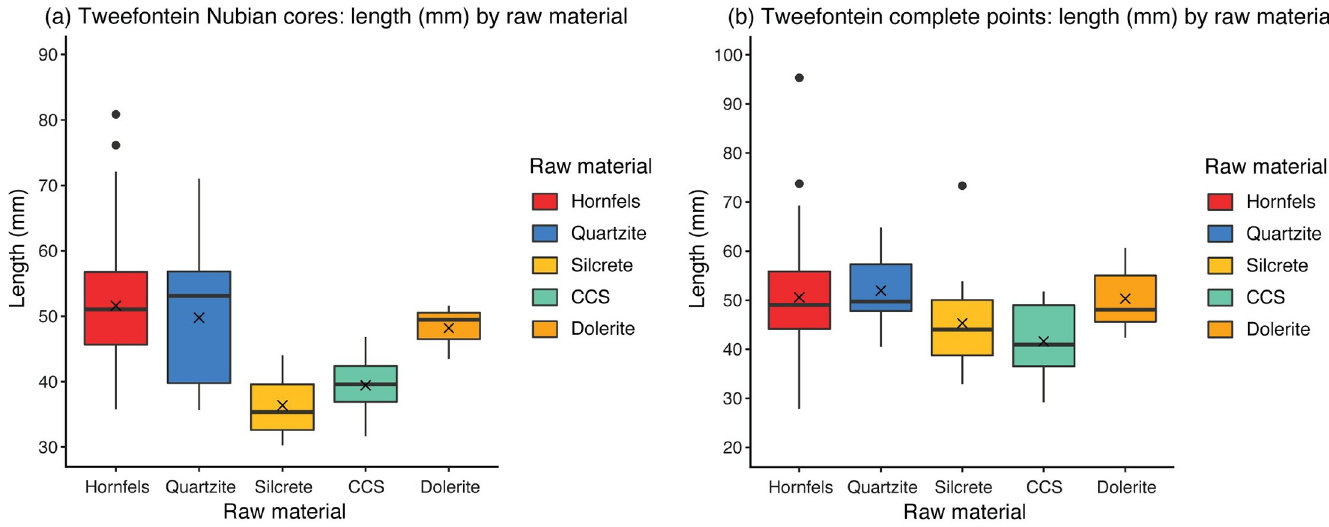
Fig 12. Box plots showing artefact length by raw material. (a) Nubian core and (b) points.